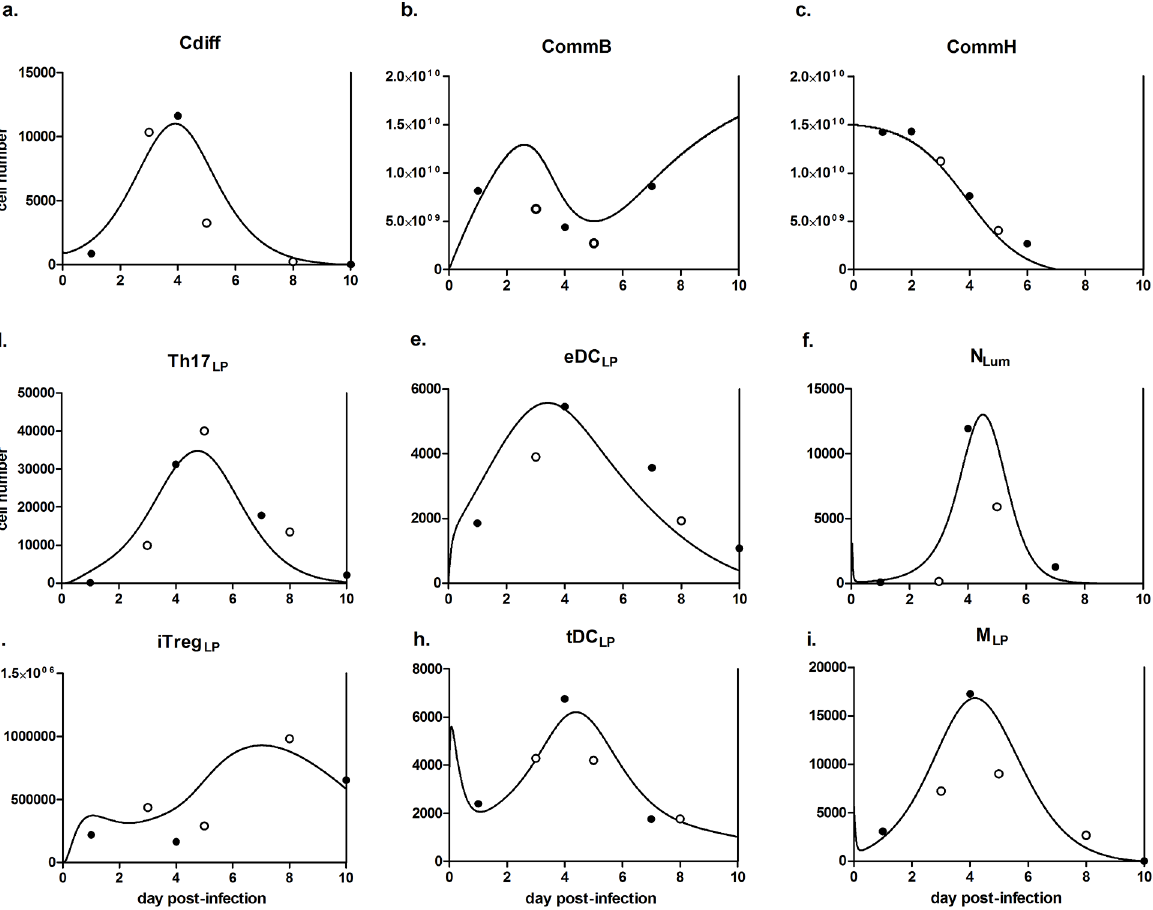
Fig 3. Simulated dynamics of mucosal immune response to Clostridium difficile . Modeling results following calibration and validation of the host response model in populations of (a) C . difficile , (b) protective commensal bacteria, (c) infection-exacerbating commensal bacteria, (d) lamina propria T helper 17 cells, (e) effector dendritic cells, (f) infiltrating neutrophils, (g) regulatory T cells, (h) tolerogenic dendritic cells and (i) activated macrophages. Lines represent simulation results, filled points represent experimental calibration data and unfilled points represent experimental validation data.